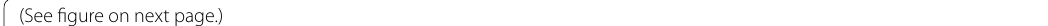
μm(See figure on next Fig. 3 Micrographs showing the developing protocorm of G. elata associated with Mycena . a Light micrograph showing the colonized region of a developing protocorm. The epidermal cell (E) contains intact fungal hyphae (arrow), and digested fungal hyphae (arrowhead) are present in the cortical cell (C). Scale bar 10 μm. b In the epidermal cell, a number of intact fungal hyphae (F) are present and are separated from the host = cytoplasm by an enveloping interfacial matrix and host plasma membrane. Scale bar 2 μm. c The penetration of fungal hyphae into the cortical = cell (arrow). Inside the cortical cell, fungal hyphae are digested and become compressed (arrowheads). Scale bar 2 μm. d After fungal hyphae = penetrate the cortical cell, the fungal wall becomes thickened (arrow) by wrapping around additional material of the interfacial matrix and/or host plasma membrane cover. Scale bar 1 μm. e In the cortical cell, several electron‑dense endocytic tubules (arrows) attach a digesting fungal hypha. = In cross sections, the tubular networks appear as numerous vesicles. Scale bar 1 μm. f A compressed fungal hypha is surrounded by numerous = electron‑dense endocytic tubules. Scale bar 1 =